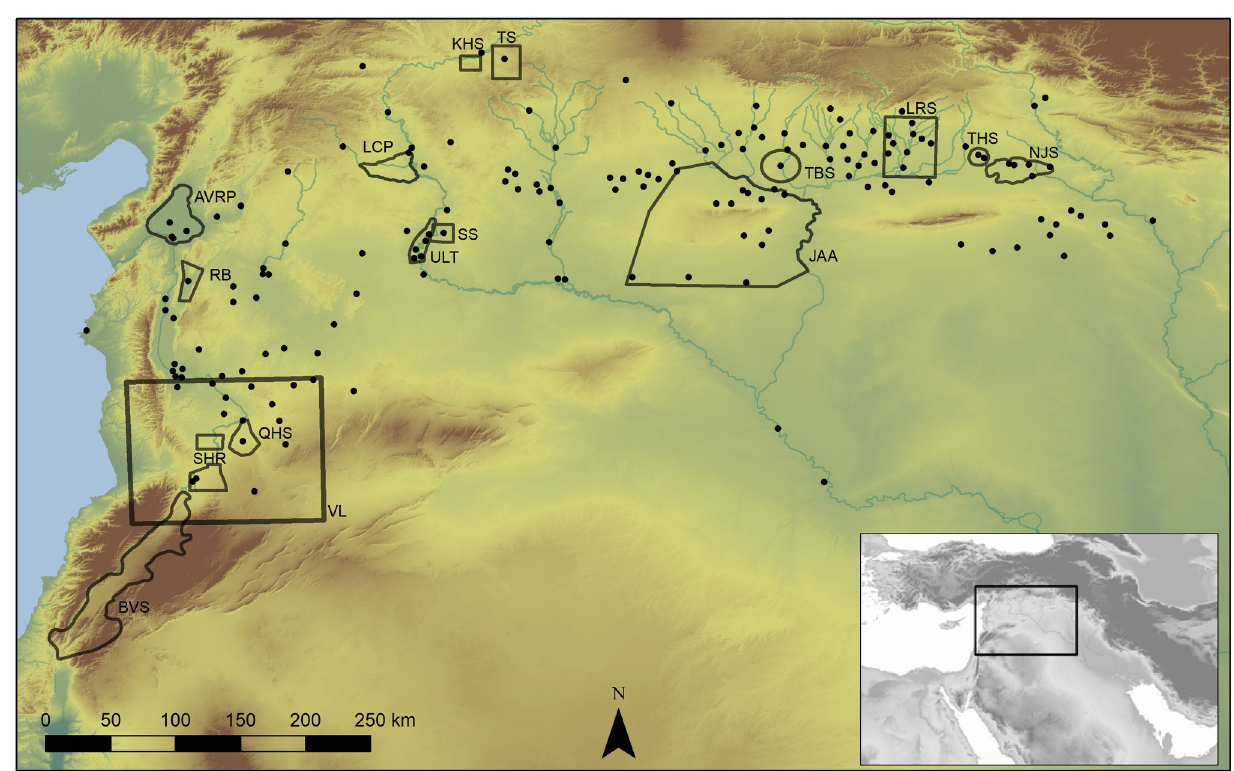
Fig 1. Study area with urban sites and survey areas. Black dots represent urban site points, polygons represent survey extents. See Table 1 for survey abbreviation. Background NASA JPL. NASA Shuttle Radar Topography Mission Global 3 arc second number. 2013, distributed by NASA EOSDIS Land Processes DAAC, https://doi.org/10.5067/MEaSUREs/SRTM/SRTMGL3N.003.